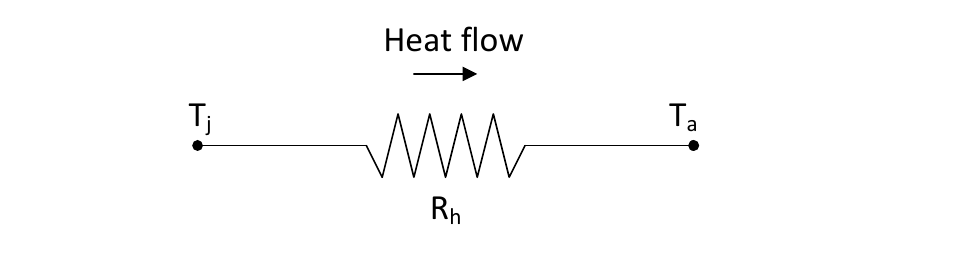
Figure 4. Thermal resistance of heatbed model.